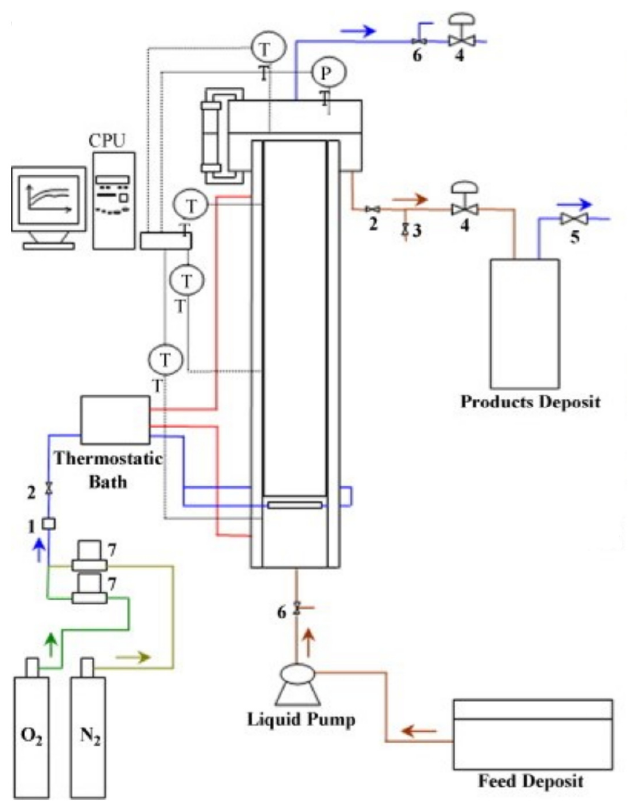
Figure 9. Schematic diagram of the pilot setup for the continuous production of phenolic monomers from lignin: (1) safety valve; (2) on–off valve; (3) electromagnetic valve; (4) needle valve; (5) safety valve; (6) three-way valve; (7) mass flow controller; PT—pressure transducer; TT—thermocouple. (Reprinted from [55] Copyright 2009, with permission from Elsevier.)